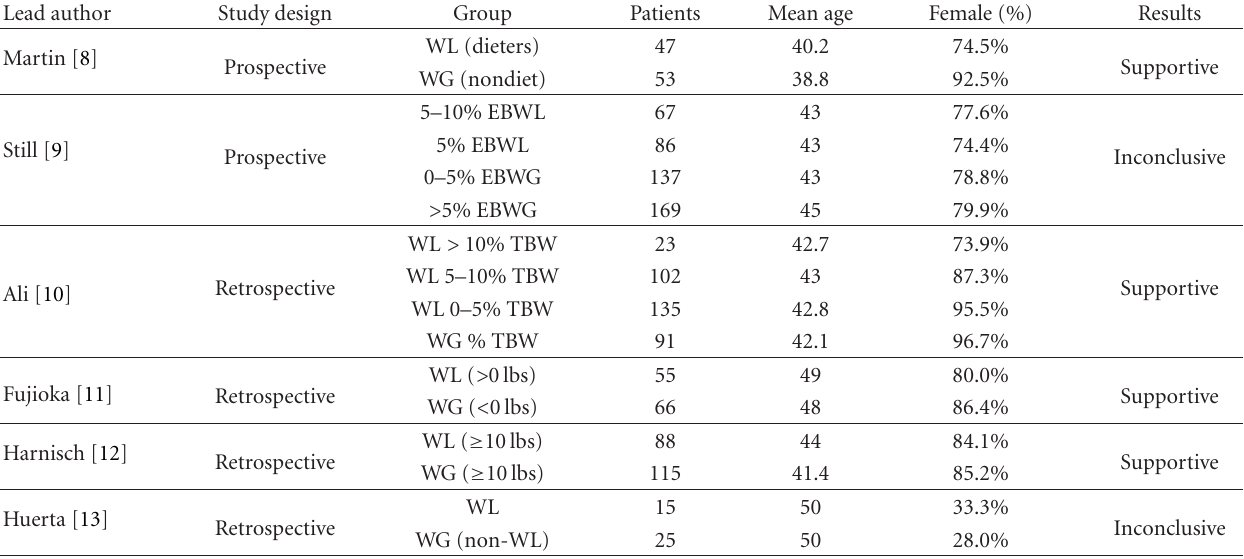
Table 2: Class B studies.